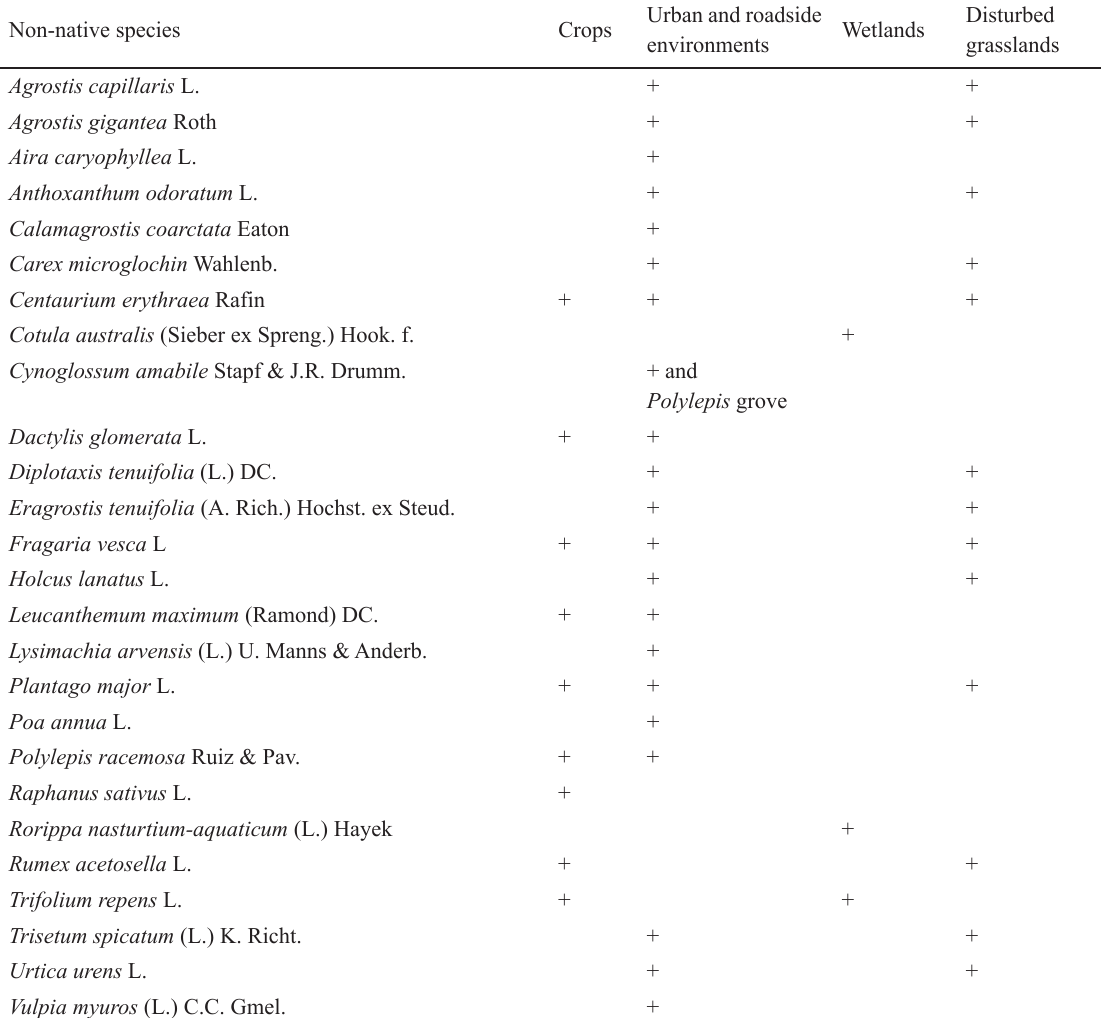
Table 2. Non-native species in the catalogue and their distribution according to the habitats where they occur. Non-native